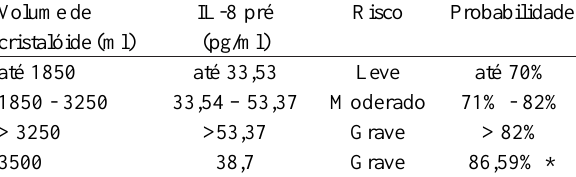
Tabela 6. Intervalos numéricos e categorias de